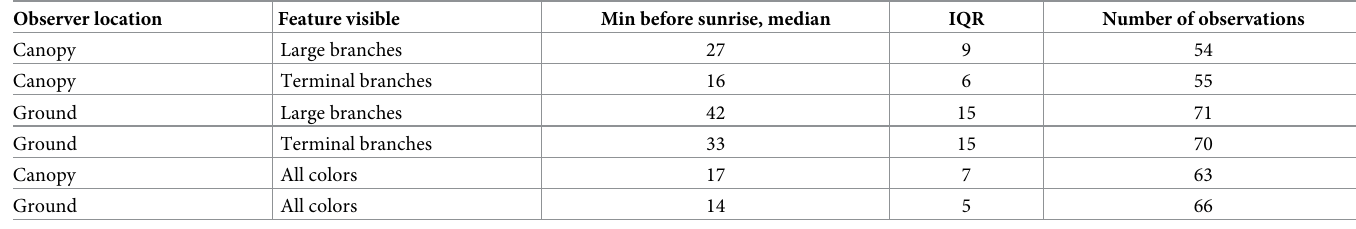
Table 3. Times when canopy features became visible to human observers.